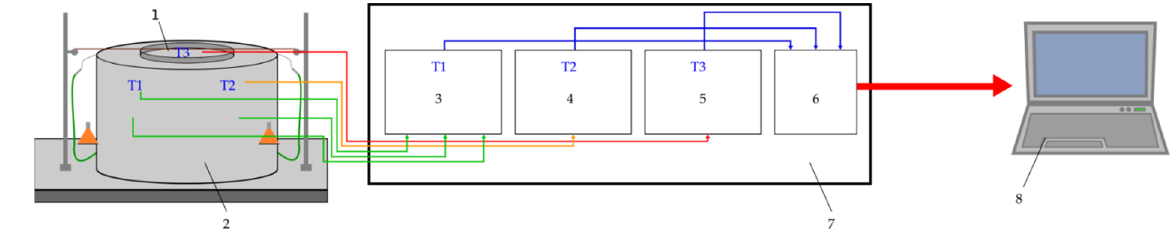
Figure 9. Scheme of measurement equipment for minimum ignition temperature of the tobacco dust layer [7]: (1) dust filling ring, (2) hot plate, (3–5) thermocouples, (6) USB PIC controller, (7) control and data-acquisition block, and (8) PC (personal computer).